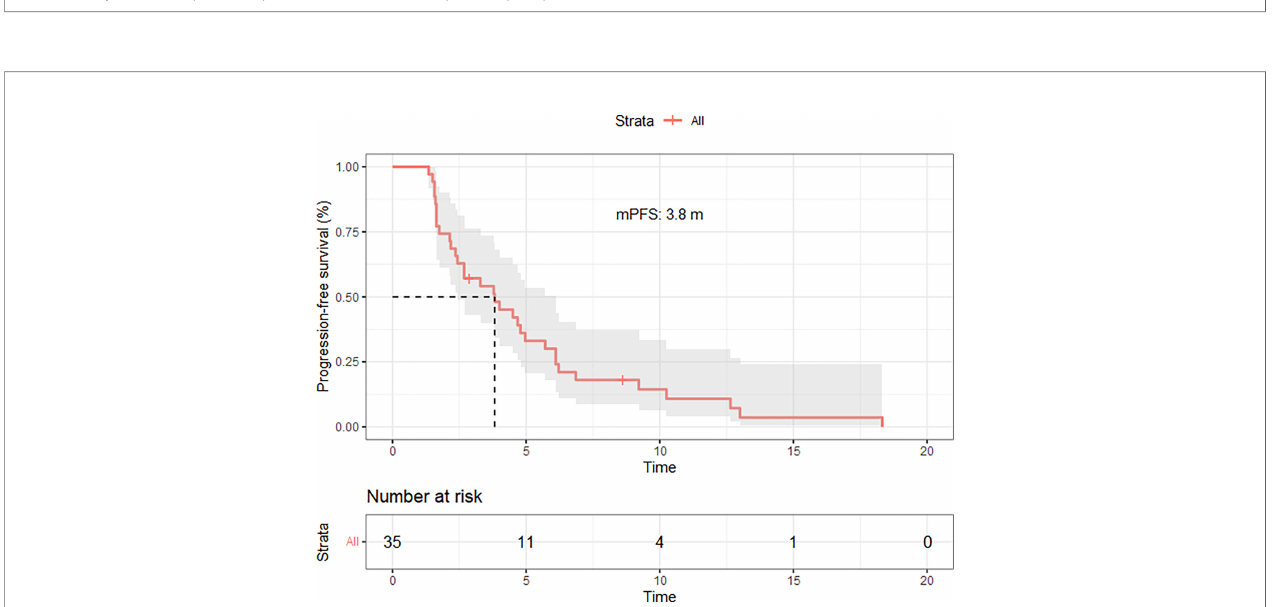
FIGURE 2 | Progression free disease of patients treated with fruquintinib plus pd-1